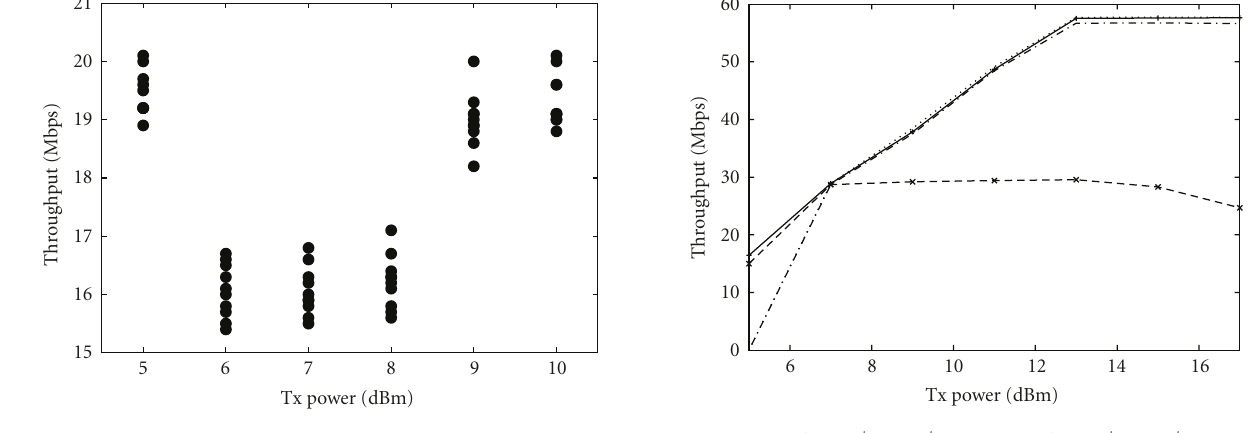
Figure 13: Impact of the transmission power configured on the performance of a single 802.11g link.